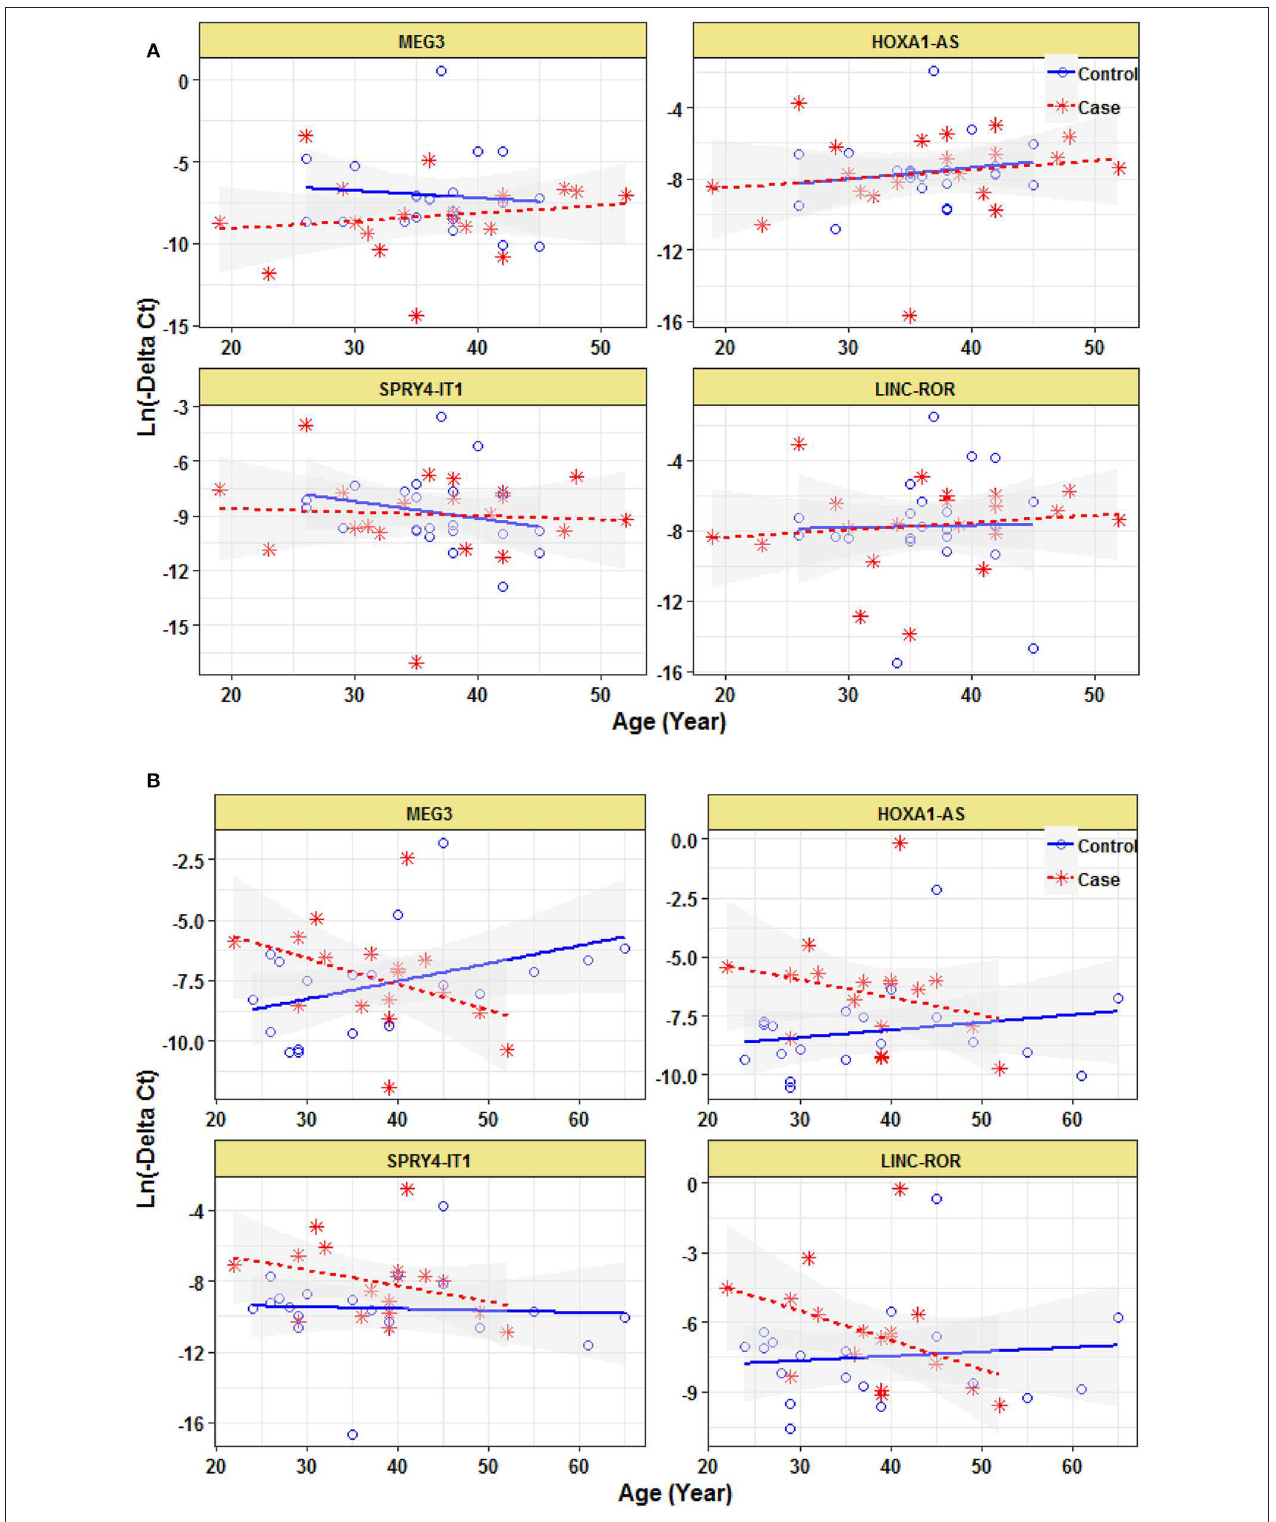
FIGURE 3 | Correlation between expression levels of lncRNAs and age in female epileptic patients and healthy subjects (A) and male epileptic patients and healthy subjects (B) .